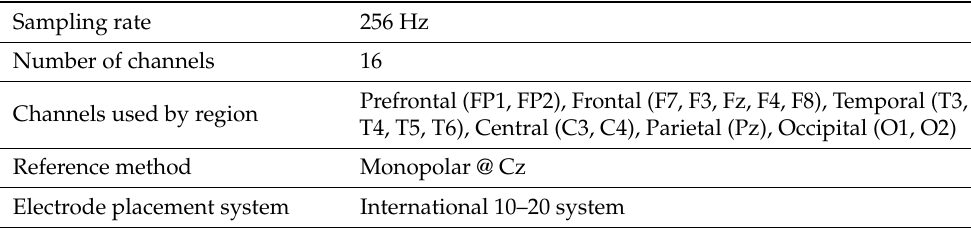
Table 1. EEG recording system